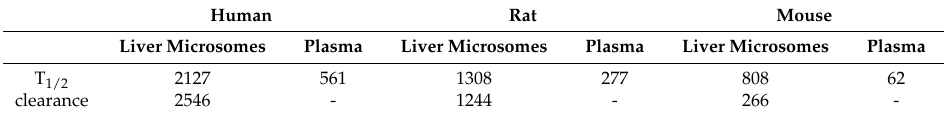
Table 2. The number of compounds present in each dataset used for the predictive model’s